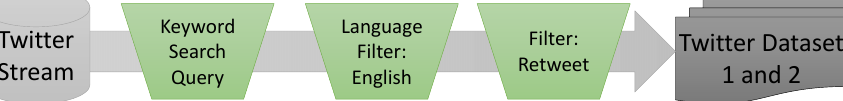
Figure 1. Workflow for sentiment analysis on Twitter data using TextBlob and VADER.